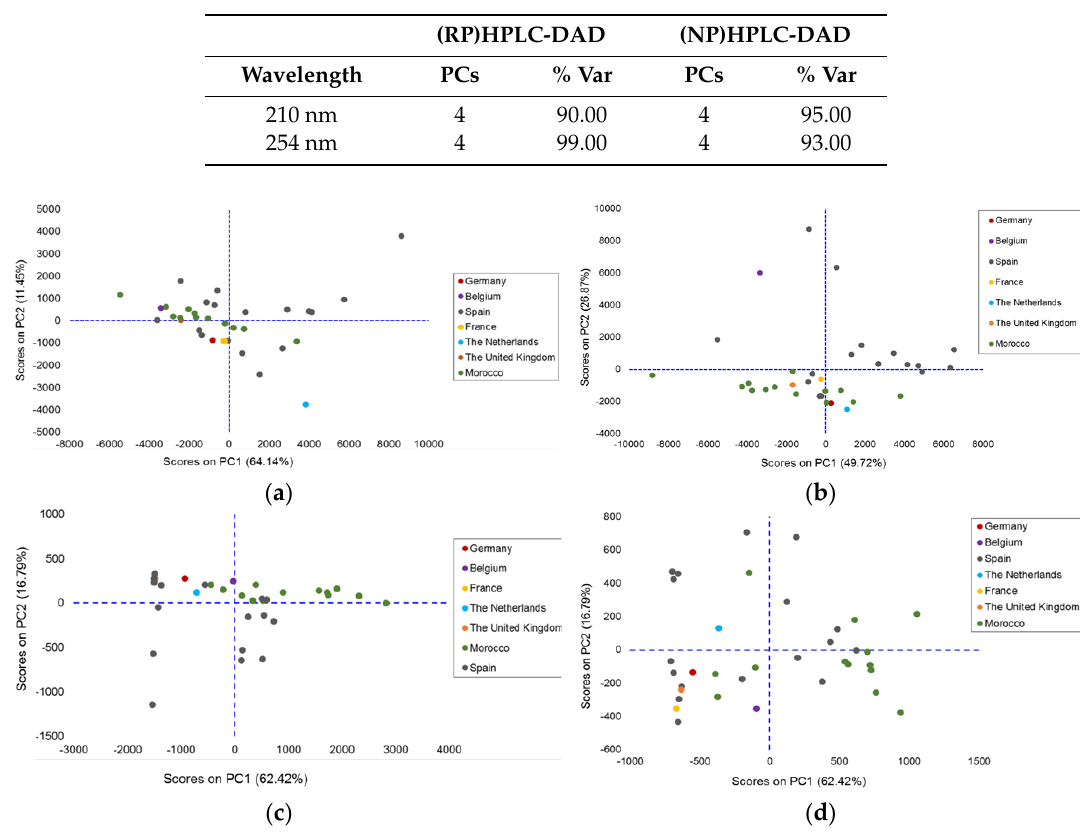
Table 3. Characteristics of the principal components analysis (PCA) models.